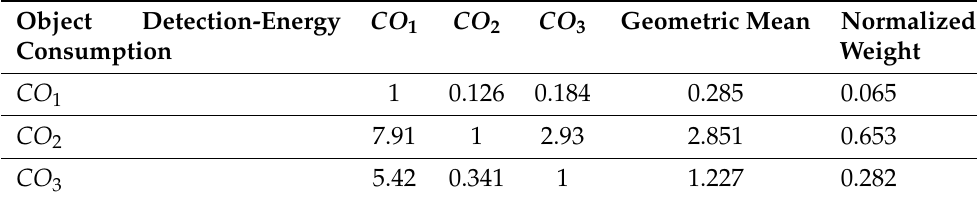
Table 8. Comparison between suitable components for object detection with respect to energy